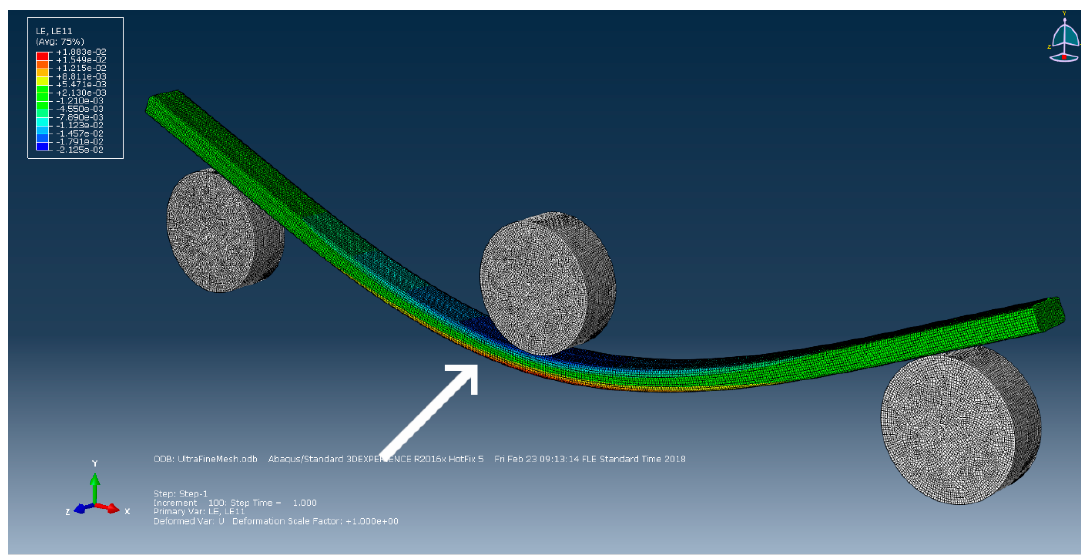
Figure 3. Location of strain hot spot in simulated three-point bending.